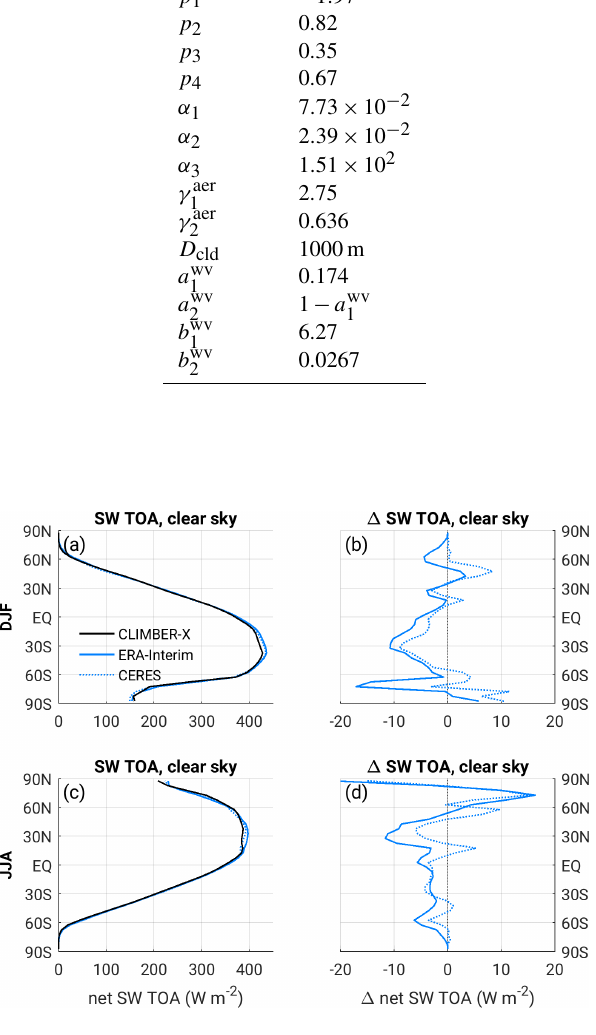
Figure A1. Zonal mean net shortwave radiation at the top of the at- mosphere for clear-sky conditions as computed by the CLIMBER- X radiation code in the offline set-up compared to ERA-Interim re- analysis (Dee et al., 2011) and CERES satellite observations (Loeb et al., 2018). Panels (a) and (b) are for December–January–February and panels (c) and (d) are for June–July–August. Panels (a) and (c) show absolute values, while panels (b) and (d) show model biases.